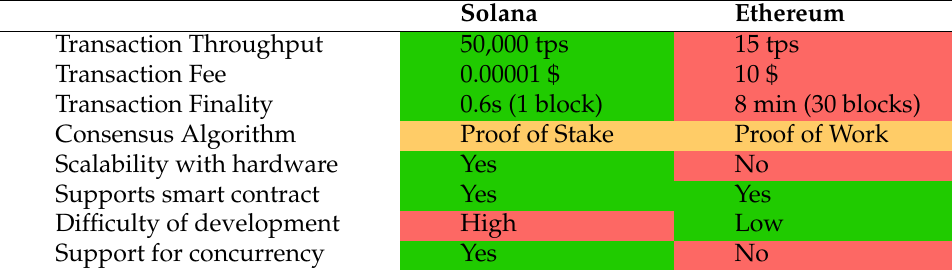
Solana Ethereum